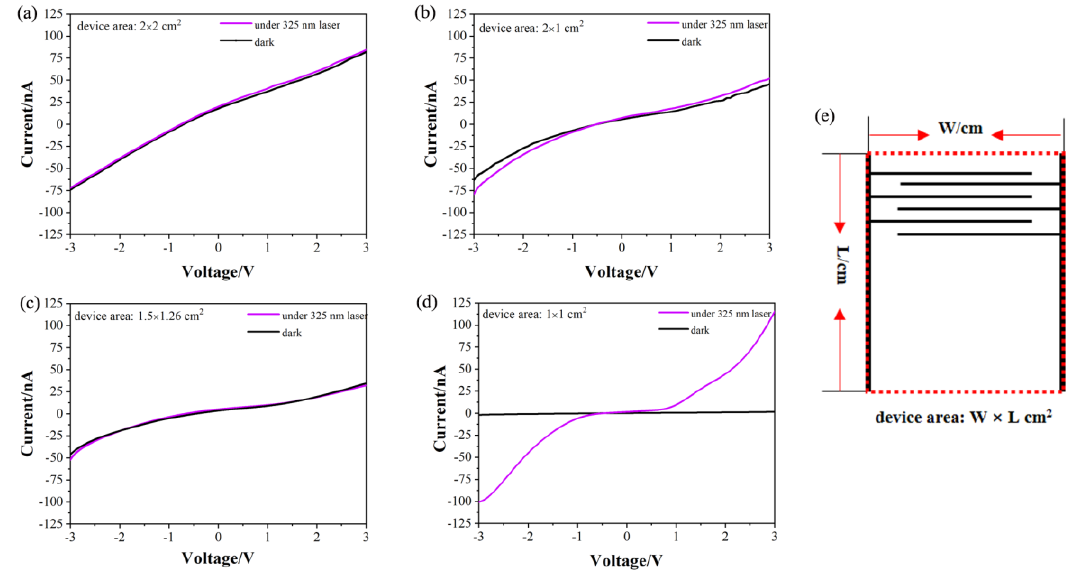
Figure 4. Current-voltage ( I - V ) curves of PDs with different device areas: ( a ) 2 × 2 cm 2 ; ( b ) 2 × 1 cm 2 ; ( c ) 1.5 × 1.26 cm 2 ; and ( d ) 1 × 1 cm 2 under 325 nm laser. ( e ) Schematic view of device area (W × L, red dotted border) on the Au interdigitated electrode.